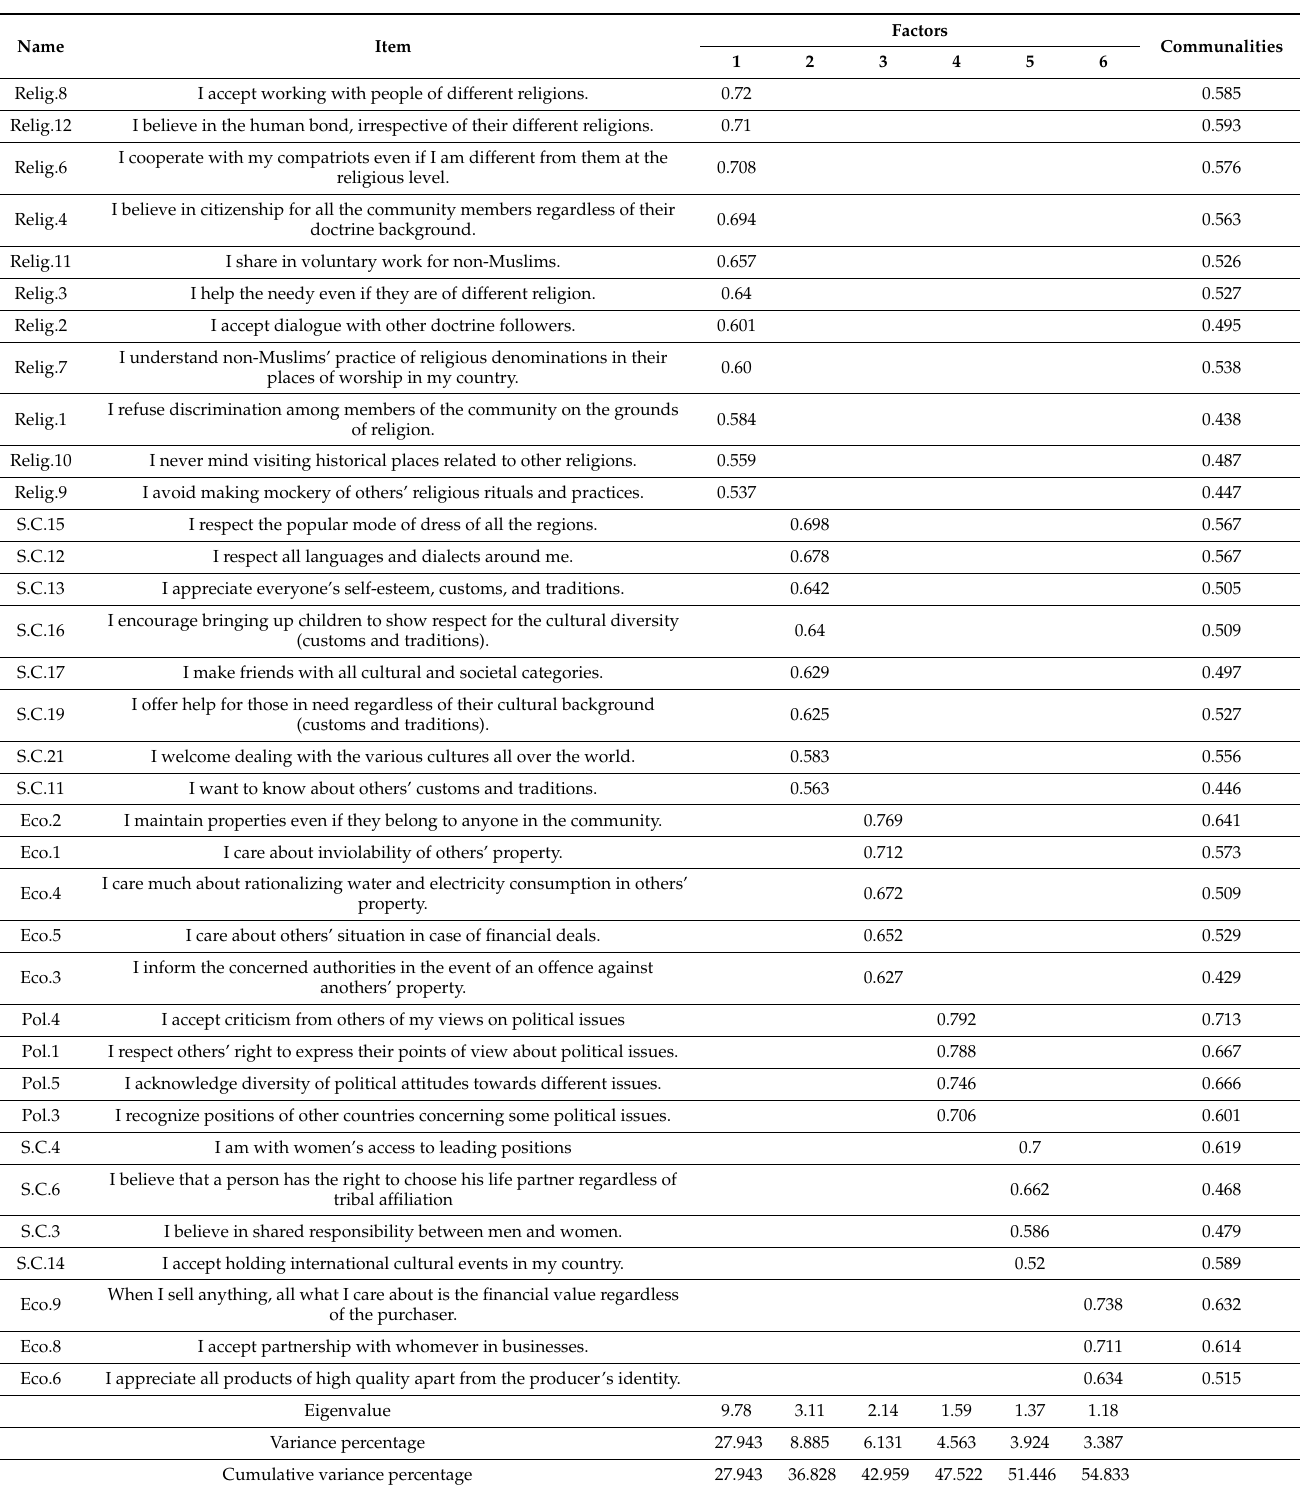
Table 3. Shows an outline of Eigenvalues of Tolerance Index